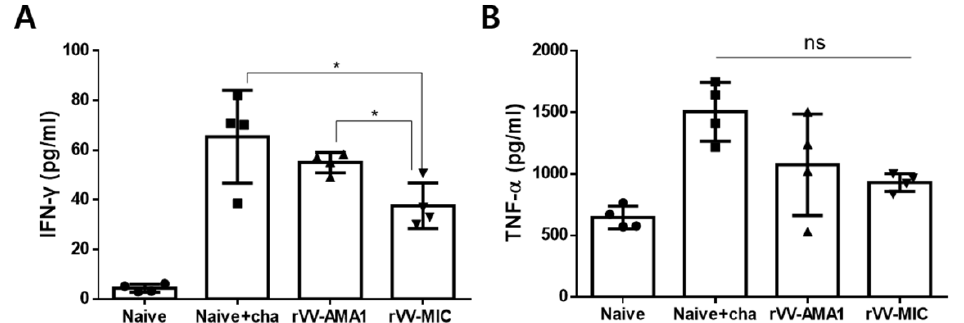
Figure 5. Inflammatory cytokine production in the spleen. Inflammatory cytokine productions were assessed from the spleens of mice at 6 dpi with P. berghei . Splenic IFN- γ ( A ) and TNF- α ( B ) cytokines were investigated using the BD OptEIA IFN- γ , TNF- α ELISA kits. Data are expressed as mean ± SD (* p < 0.05; ns: no statistical